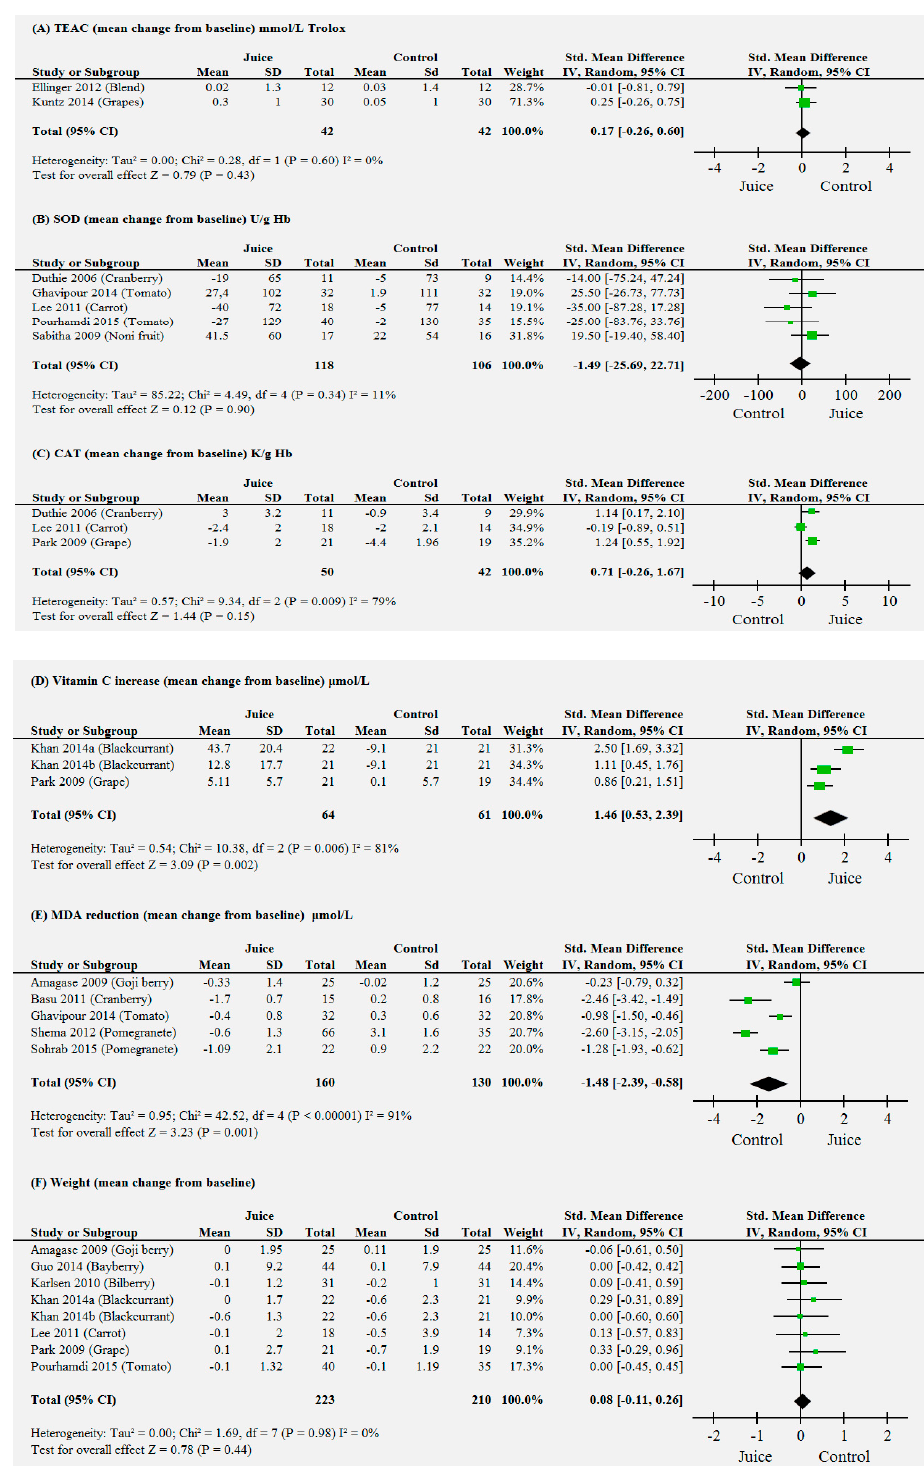
Figure 2. Forest plot for the outcome measures related to antioxidant status in the human plasma. Mean change from baseline for ( A ): Trolox equivalent antioxidant capacity (TEAC); ( B ) superoxide dismutase enzyme (SOD); ( C ): catalase enzyme (CAT). Statistical method: Mean difference (MD) and standard mean difference (SMD) (IV, Random, 95% confidence interval (CI)). Test for overall effect was performed using Review Manager Software ; ( D ): vitamin C increase; ( E ) MDA; ( F ) weight. Statistical method: SMD (IV, Random, 95% CI). Test for overall effect was performed using Review Manager Software.